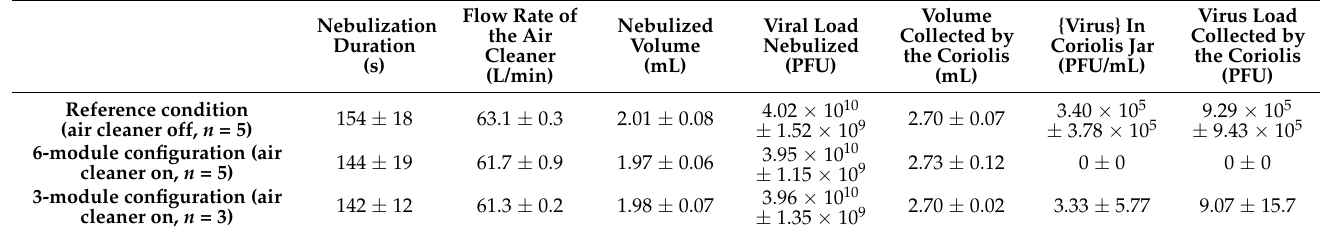
Table 1. Experimental results showing the different operating conditions: nebulization duration, the flow rate at the inlet of the air cleaner, total nebulized volume, viral load nebulized, bioaerosol volume collected by the Coriolis ® device, concentration of virus in the Coriolis ® jar, and virus load collected by the Coriolis ® device. Flow Rate of Volume Virus Load Nebulized Viral Load {Virus} In the Air Collected by Collected by Volume Nebulized Coriolis Jar Cleaner the Coriolis the Coriolis (s) (mL) (PFU) (PFU/mL) (L/min) (mL)